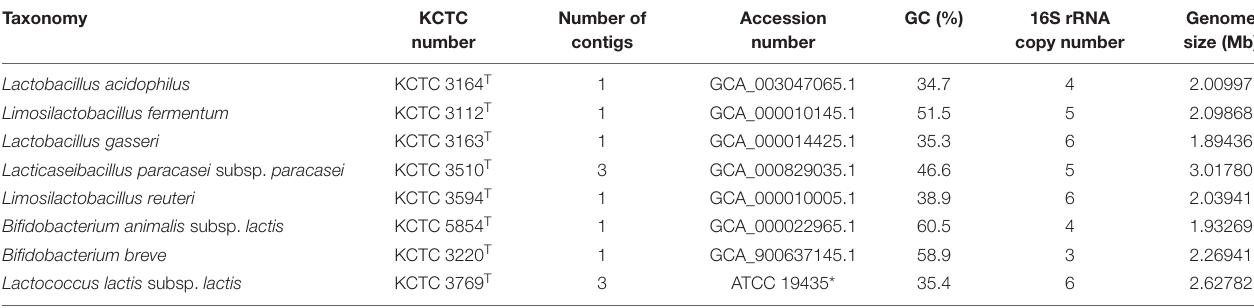
TABLE 1 | List of probiotic strains obtained from Korean Collection for Type Cultures